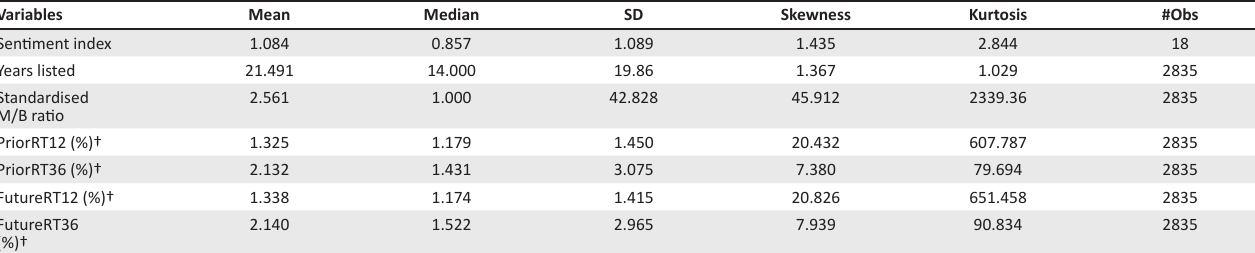
TABLE 1: Summary statistics. Variables